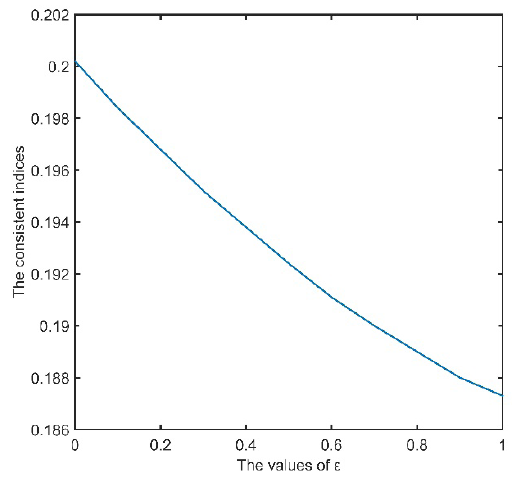
Figure 3. The distances between